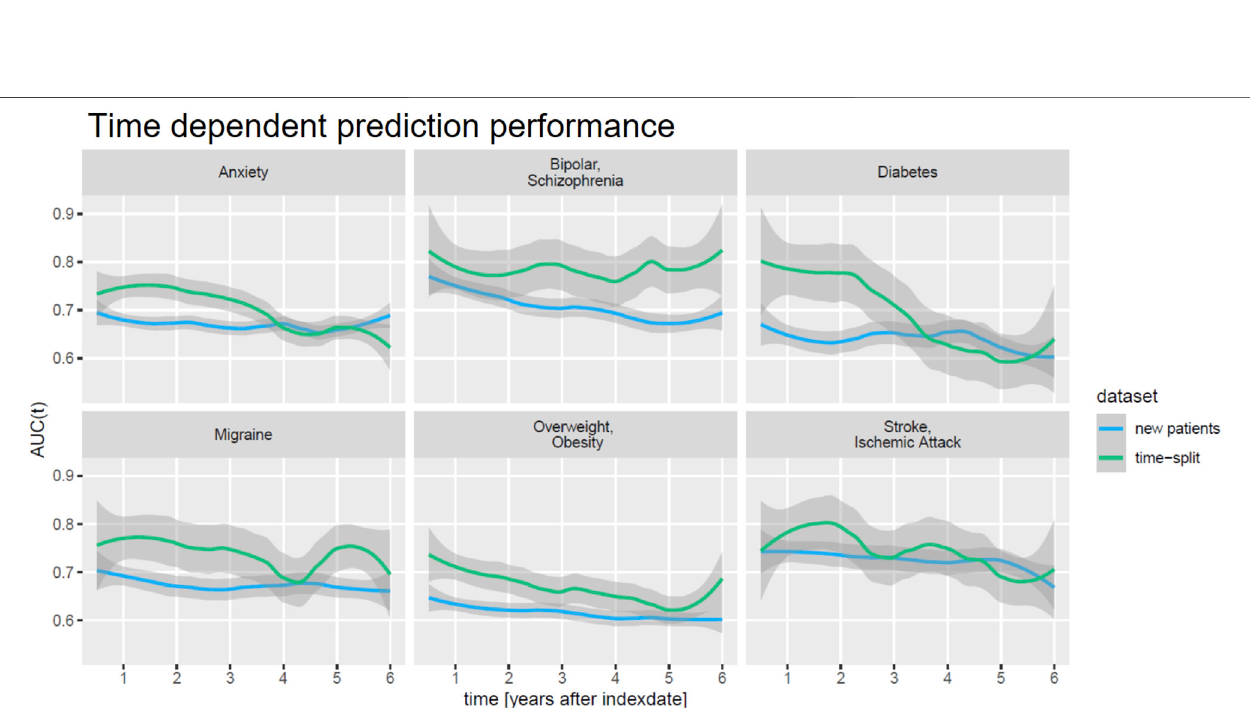
FIGURE 4 | Prediction performance of Deep LORI on external validation data. Green: time-split validation, that is, follow-up of patients included in training data. Blue: prediction performance on new patient data. Red: 5-fold cross-validated prediction performance on original data for comparison purposes.